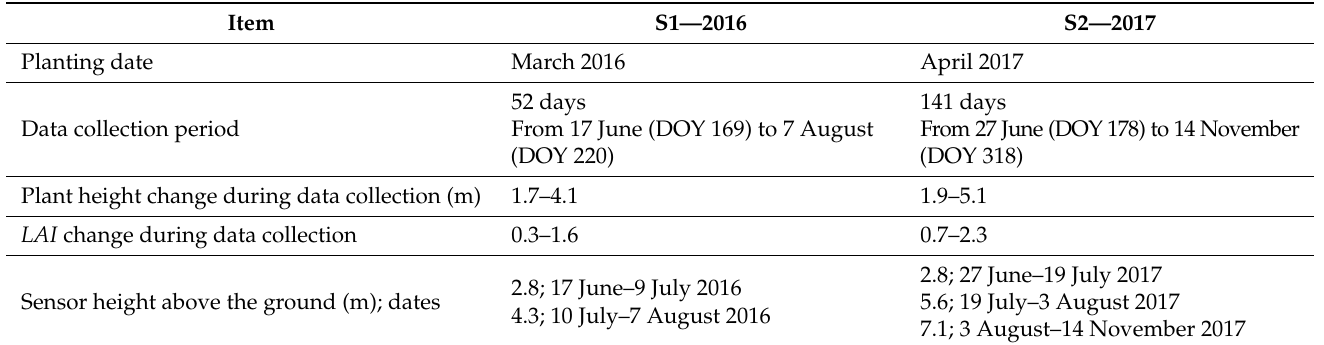
Table 1. Data about plants, measurement periods, and sensor heights during the two